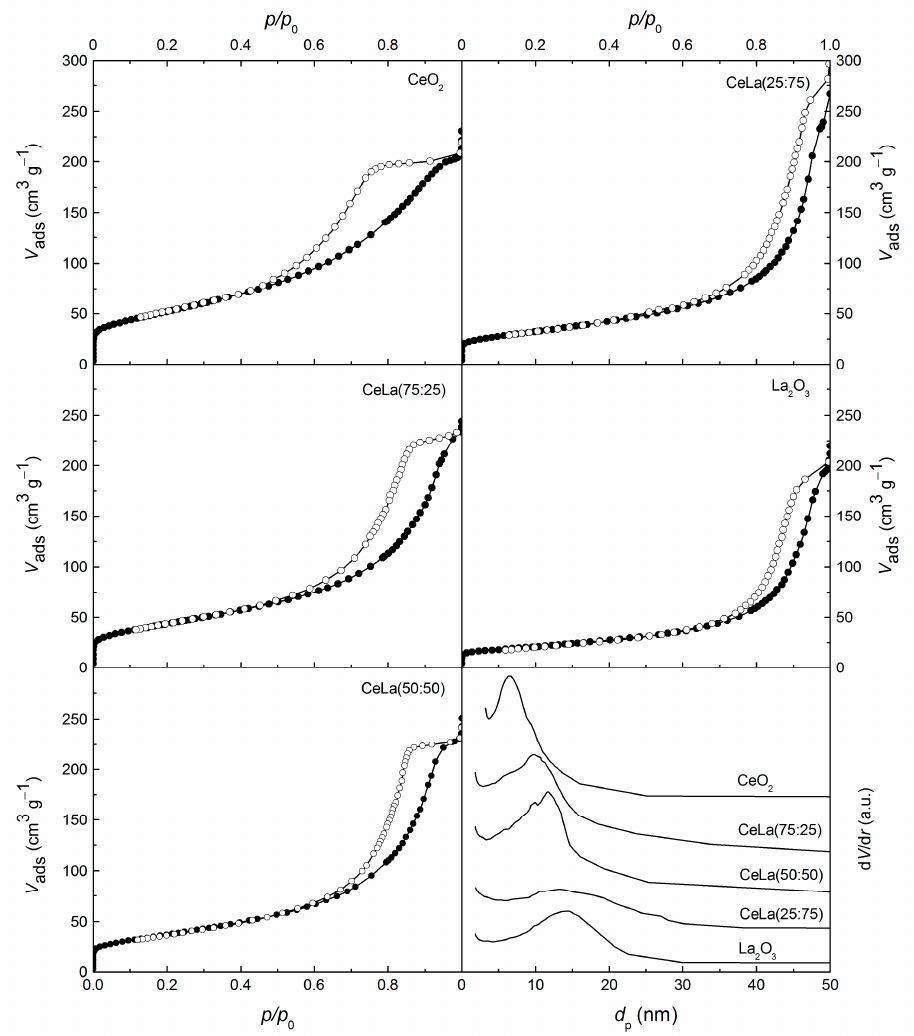
Figure 2. N 2 physisorption isotherms and pore size distribution plots of the prepared oxide catalysts. The results of the Raman characterization for CeO 2 , La 2 O 3 , and the CeLa( x : y ) mixed oxides, freshly calcined at 450 ◦ C for 4 h, are shown in Figure